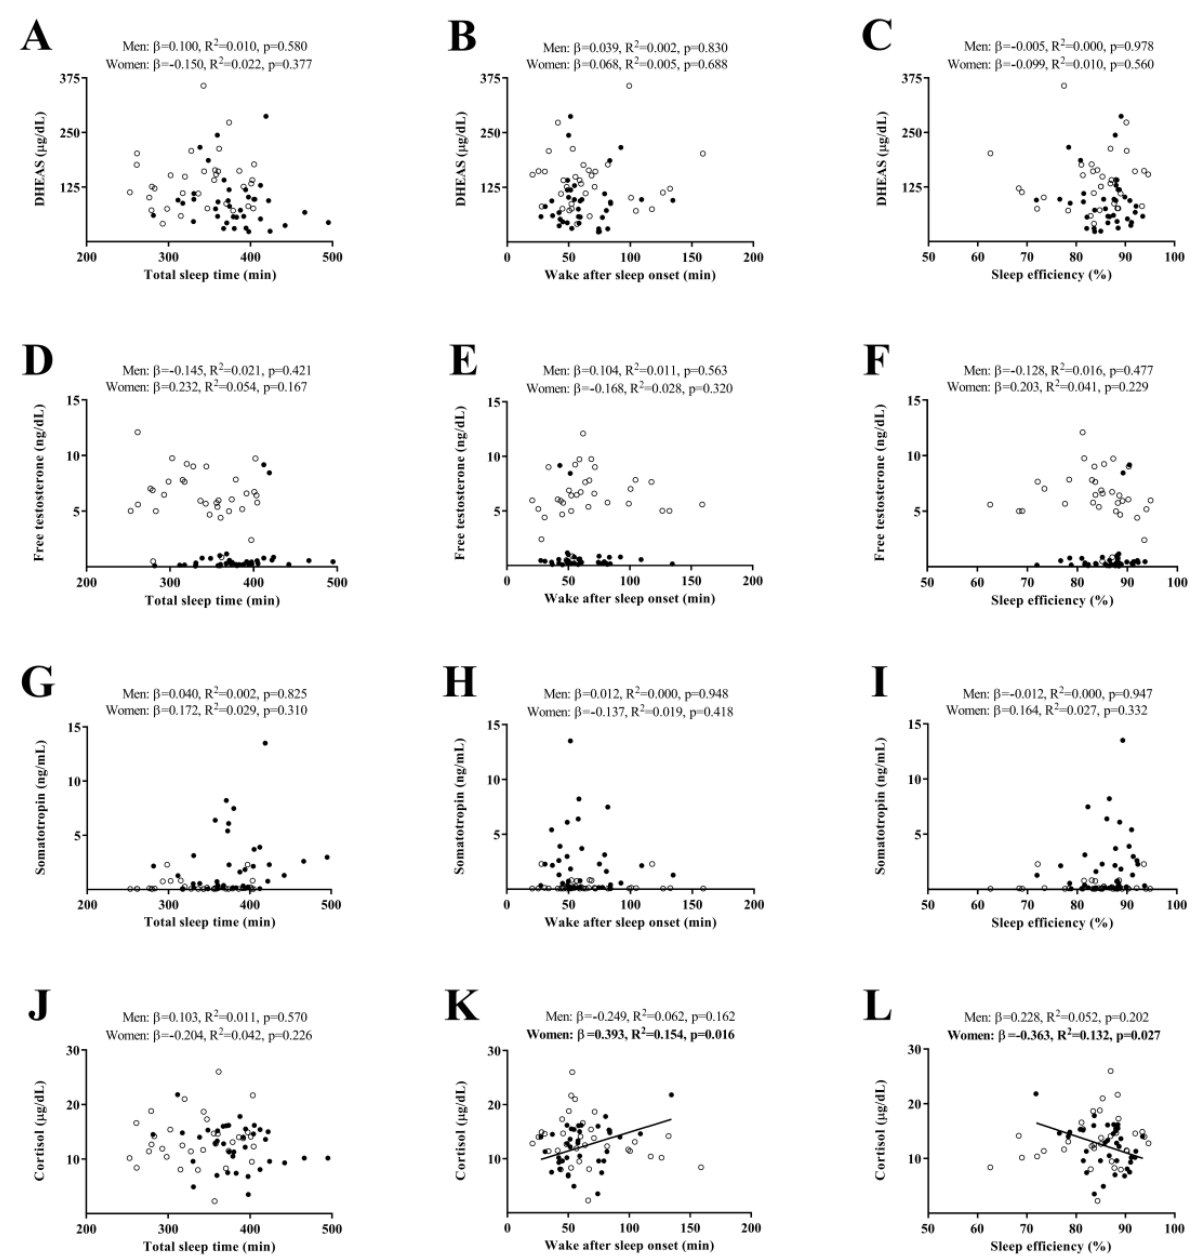
Figure 2. Association of objective sleep quantity and quality with levels of plasma hormones (Panel ( A – C ): DHEAS, Panel ( D – F ): Free testosterone, Panel ( G – I ): Somatotropin, and Panel ( J – L ): Cortisol) in sedentary middle-aged adults. β (standardized regression coefficient), R 2 , and p -value from a simple linear regression analysis. Significant p -values (<0.05) are in bold. Open circles represent men, closed circles represent women, and the straight solid line represents women. DHEAS: dehydroepiandrosterone sulphate.